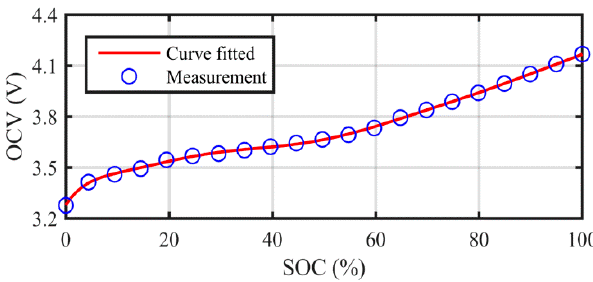
Figure 2. Measured and calibrated correlation between the SOC and OCV.